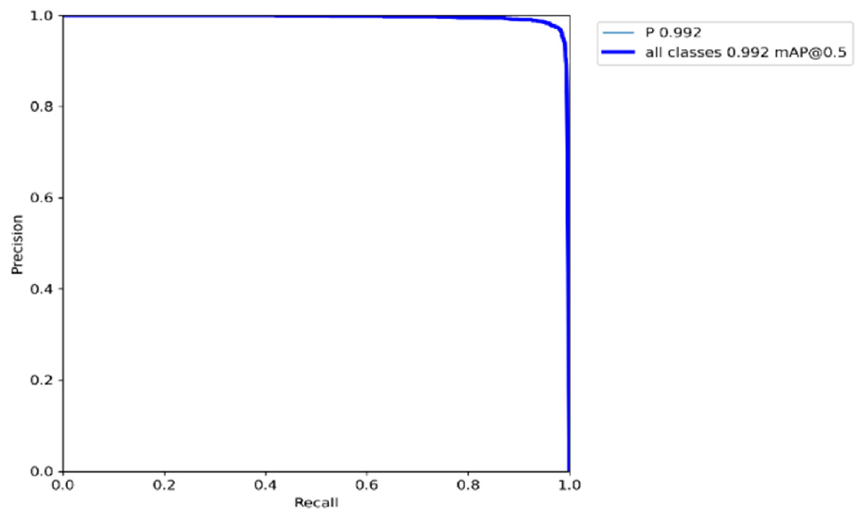
Figure 13. P–R curve.